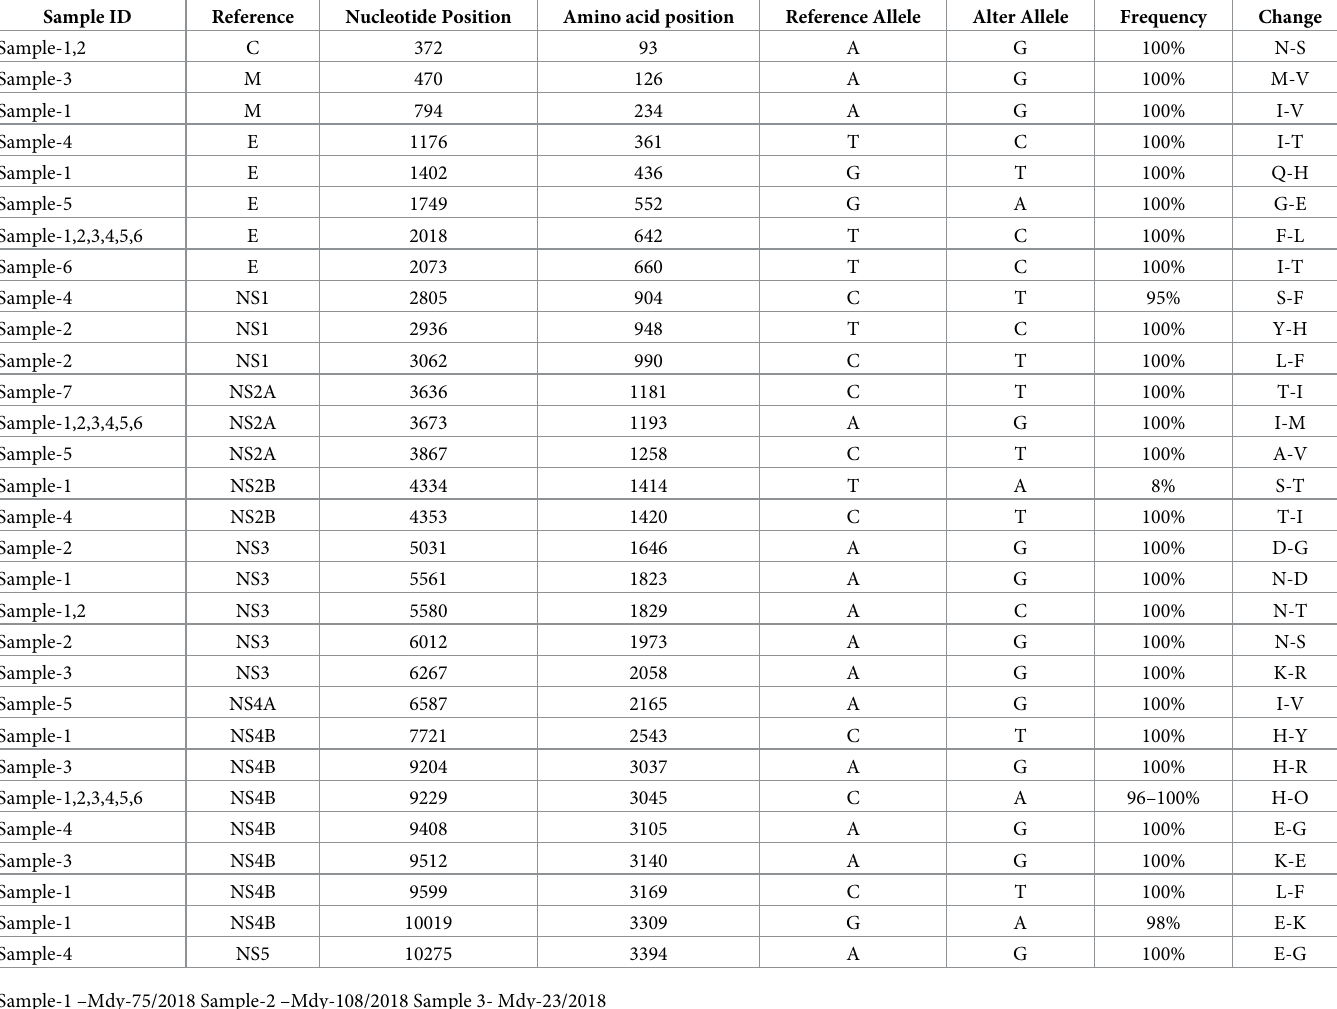
Table 5. Non-synonymous variant ( > 1%) alleles shared among the DENV-3 isolates in this